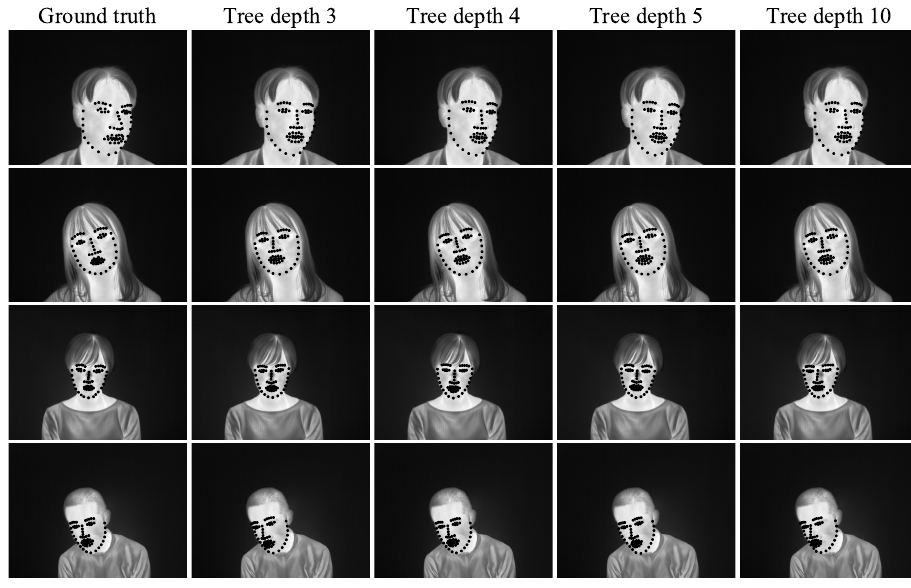
Figure 10. Examples of facial alignment using CSR for each cascade stage for tree depth = 3, 4, 5, and 10.